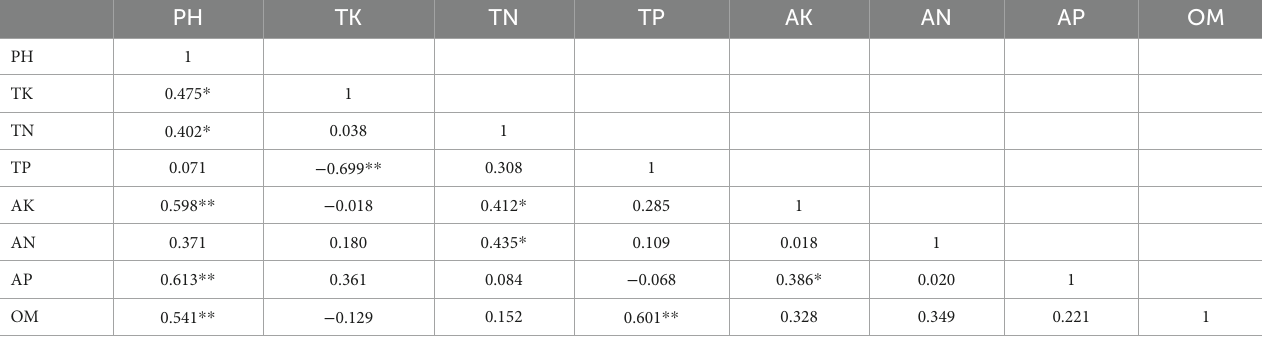
TABLE 3 Correlation of chemical Properties of Rhizosphere Soil of C.